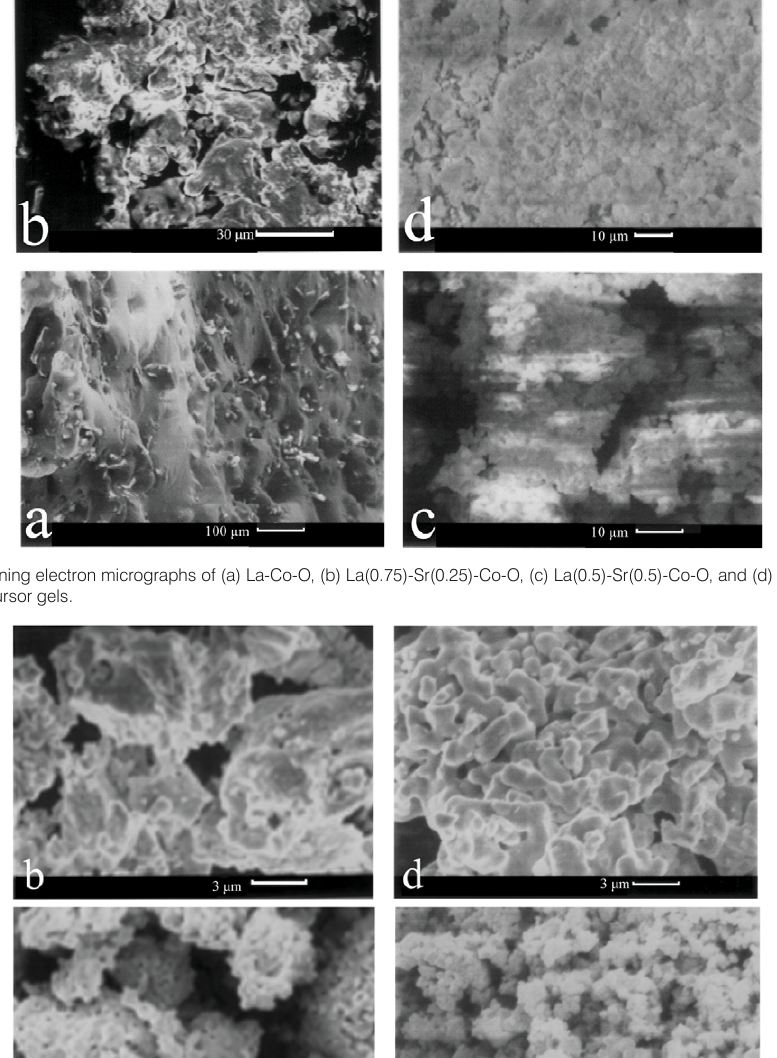
, (b) La Sr CoO , (c) La Sr CoO (d) La Sr CoO ceramics 3 0.75 0.25 3- d 0.5 0.5 3- d 0.25 0.75 3- d